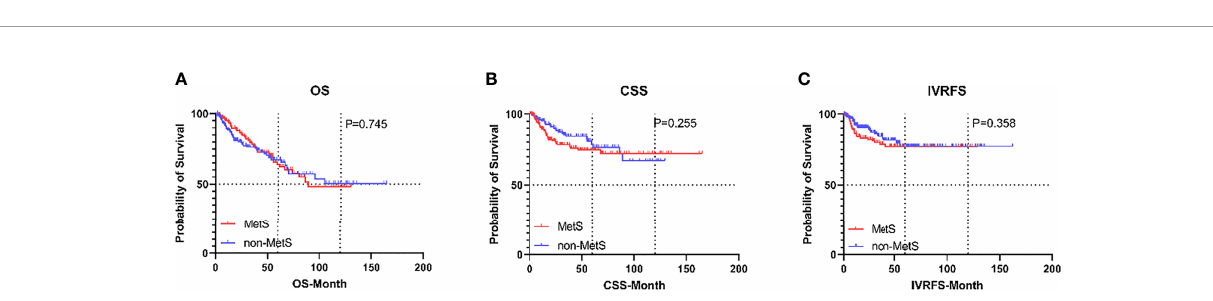
FIGURE 5 | Standardized differences in covariates between MetS and non-MetS group, prematch and postmatch: (A) Line-plot; (B) Dot-plot.